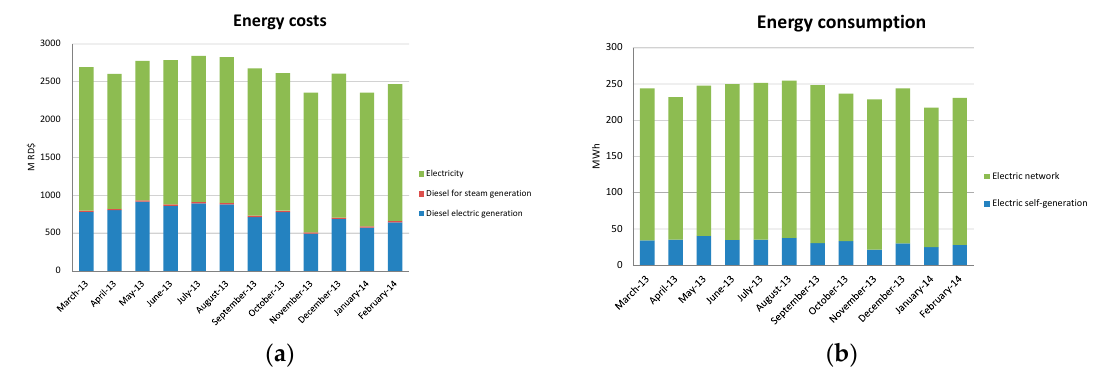
Figure 1. ( a ) Energy costs ( b ) Energy consumption.